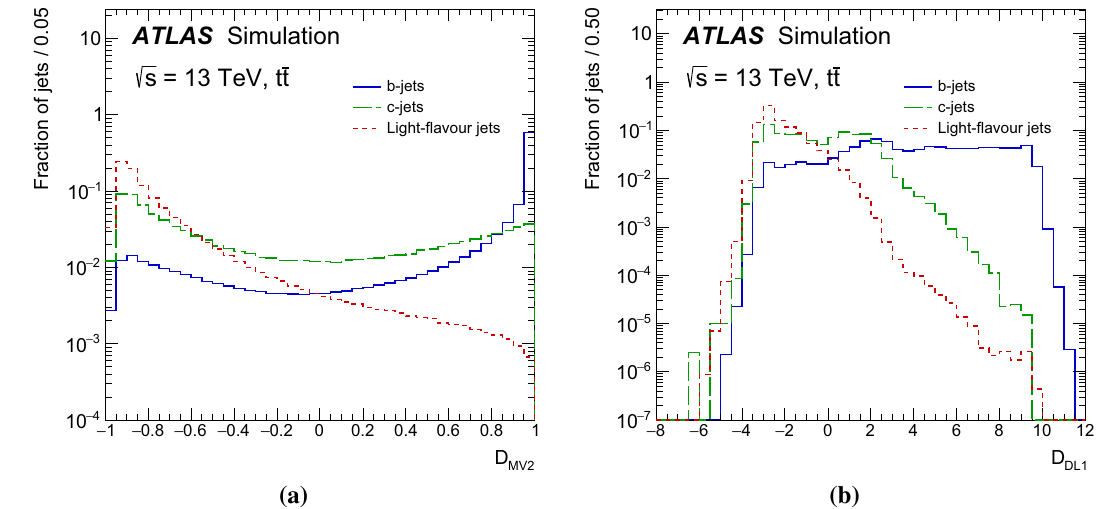
Fig. 1 Distribution of the output discriminant of the (a) MV2 and (b) DL1 b -tagging algorithms for b -jets, c -jets and light-flavour jets in the baseline t ¯ t simulated events